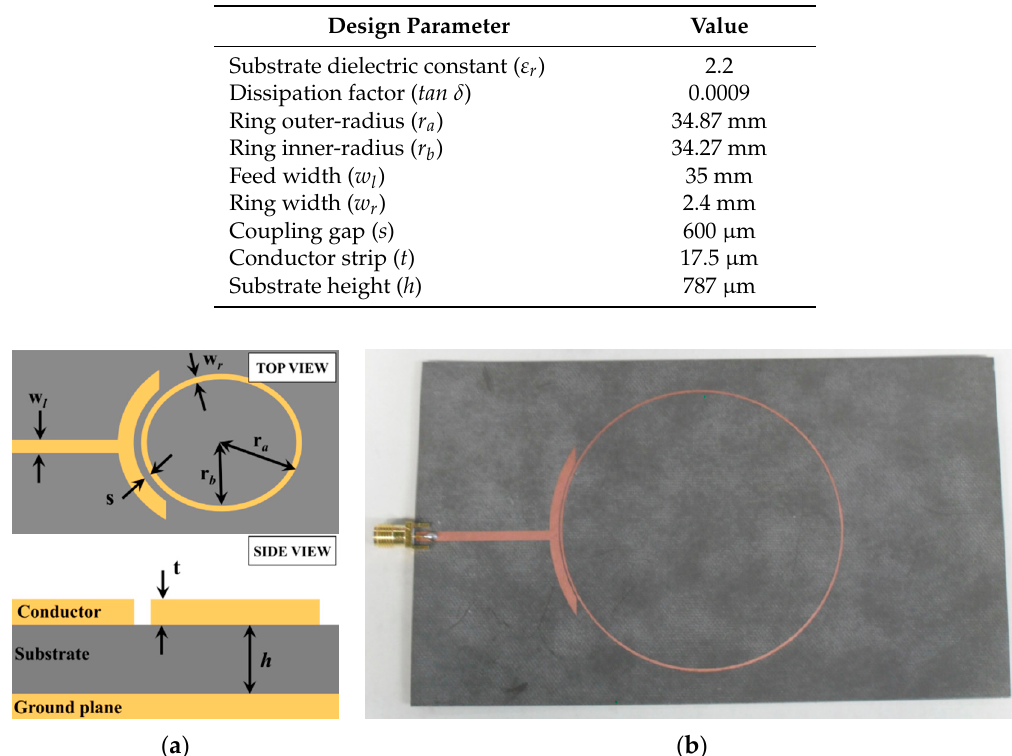
Table 1. Design parameters of a highly sensitive microwave ring-resonator sensor.